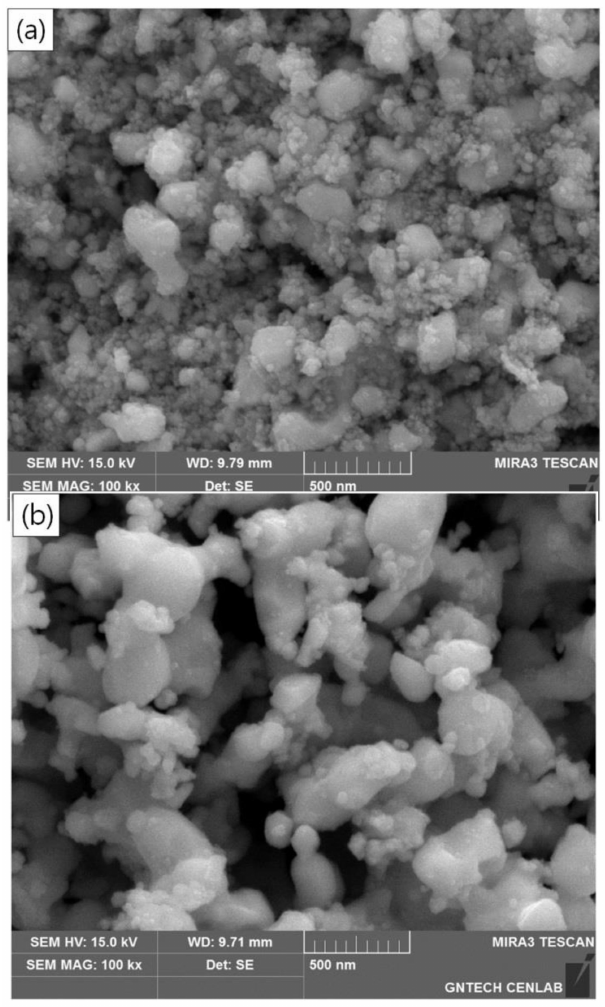
Figure 8. SEM microstructure of the Mg-reduced sample at ( a ) 1073 K and ( b ) 1173 K after acid leaching. There is a possibility that the relatively coarse particles shown in Figure 8 are poly-crystallite and are not single-crystallite. Therefore, we measured the size of the internal crystallites by using the Scherrer equation ( B = K λ / D · cos θ B ) [20], and the result is shown in Figure 9. The Scherrer equation was applied to the 1st peak in the XRD profiles. B is the full width at half maximum, HWHM (radian) is the diffraction peak, λ is the wavelength of the radiation (nm), θ B is the Bragg angle, and D is the crystallite size (nm), respectively. Figure 9 indicates that the average crystalline sizes were increased within a range of 11.5~24.7 nm according to an increase in reduction temperatures, and this was considered to be a crystal growth